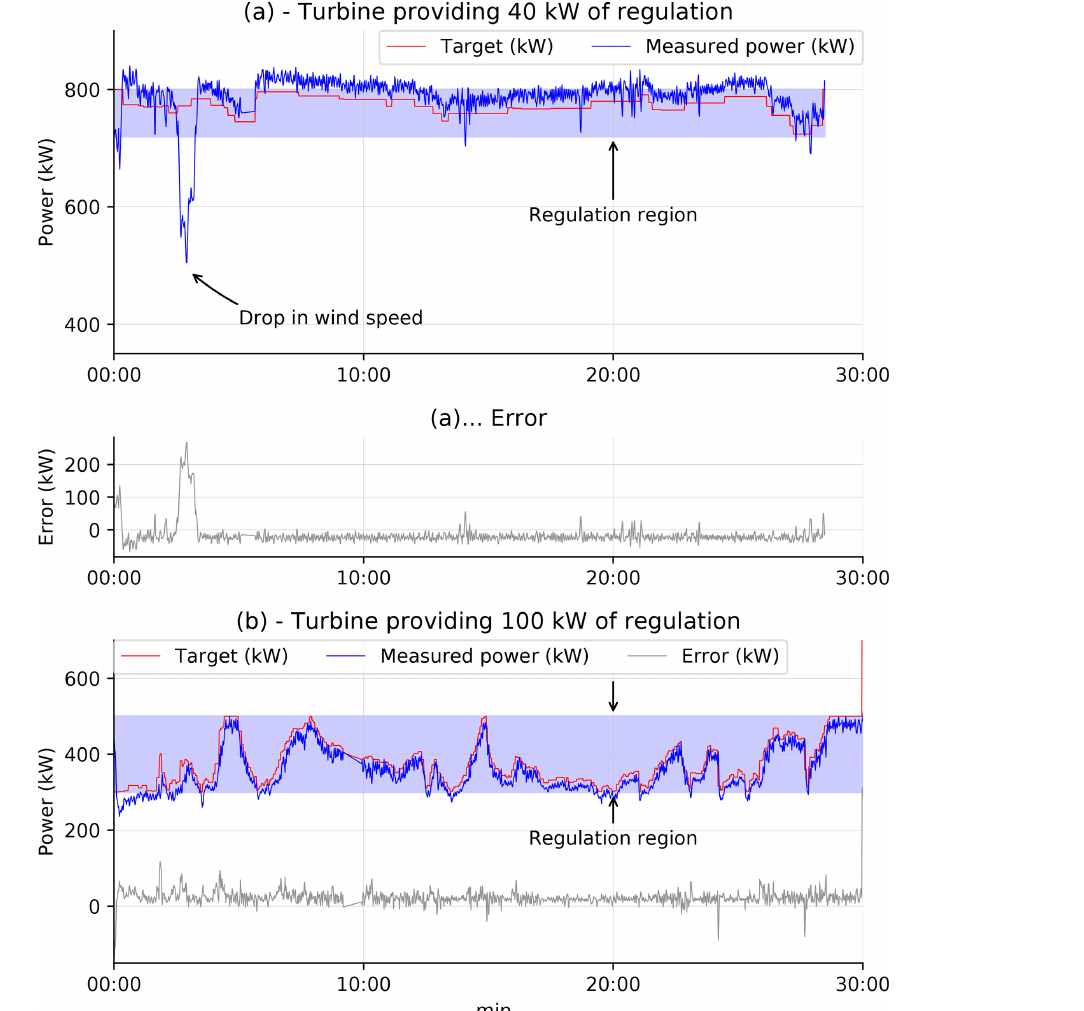
Figure 8. (a) Providing 40kW of regulation from a single 800kW wind turbine when operating at rated power. Note that the offset observed is discussed in Sect. 3.2. (b) Providing 100kW of regulation. Blue shaded region in (a) and (b) is the range of possible regulation. The diagram labelled “... (a)” continues (a)